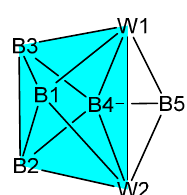
Figure 9. Core structure of cluster 27.